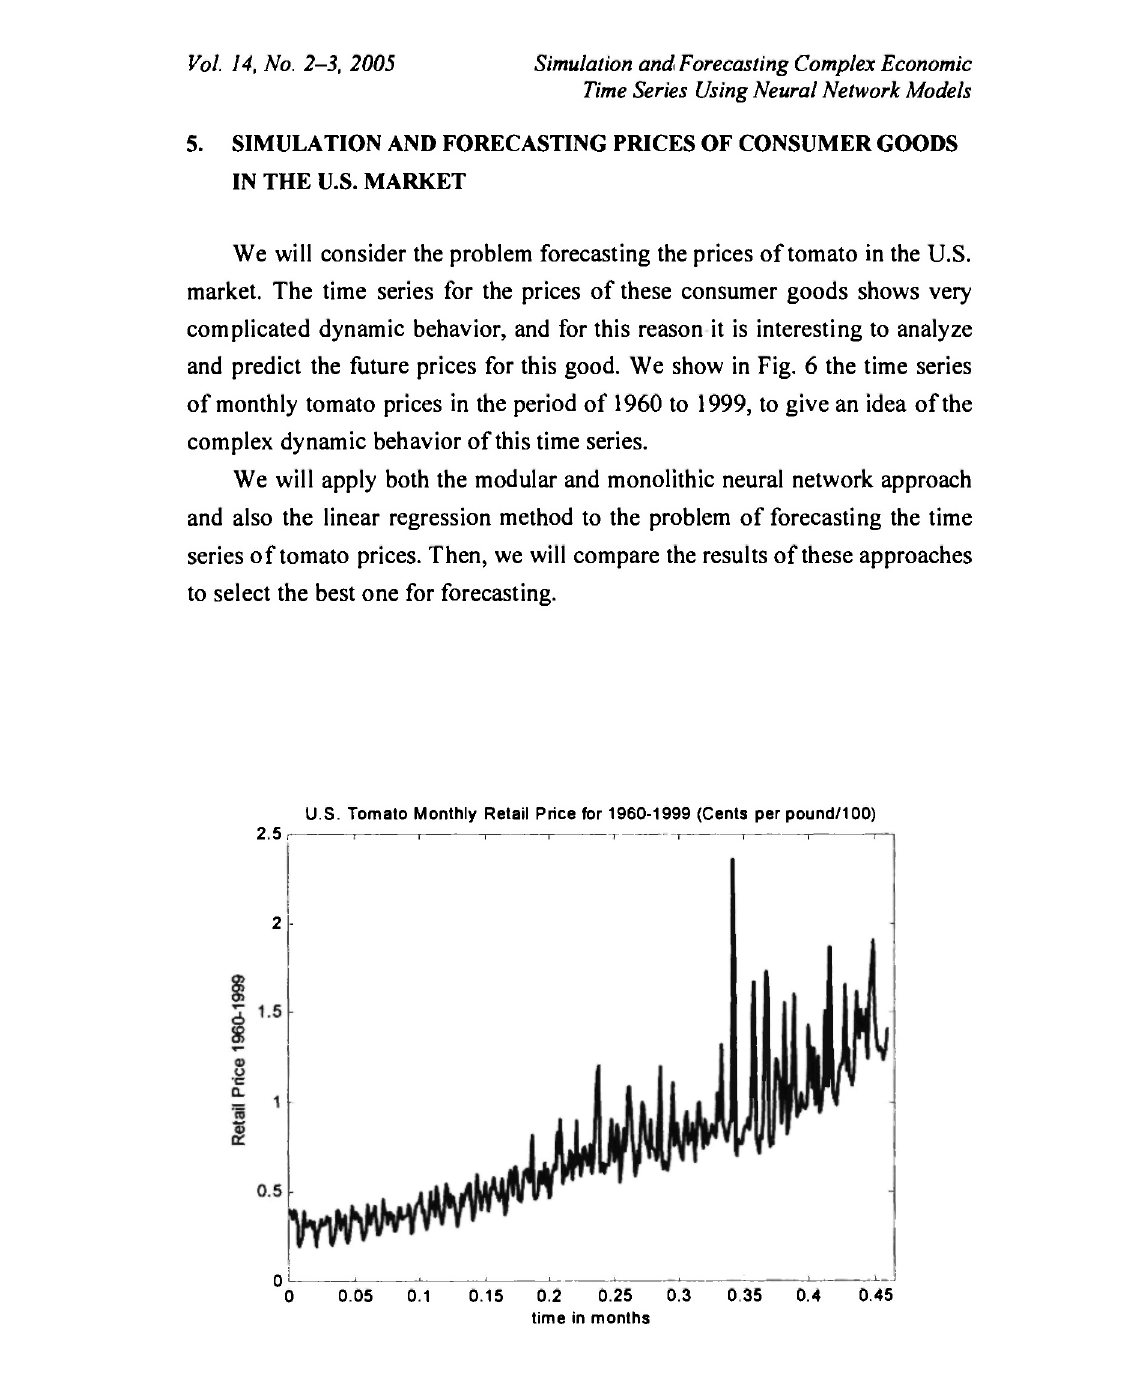
Prices in U.S. Dollars of tomato from January 1960 to December